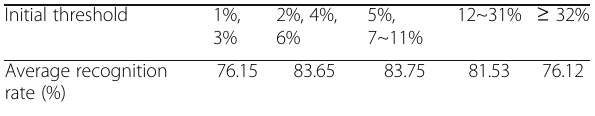
Table 12 Average recognition rate of different initial